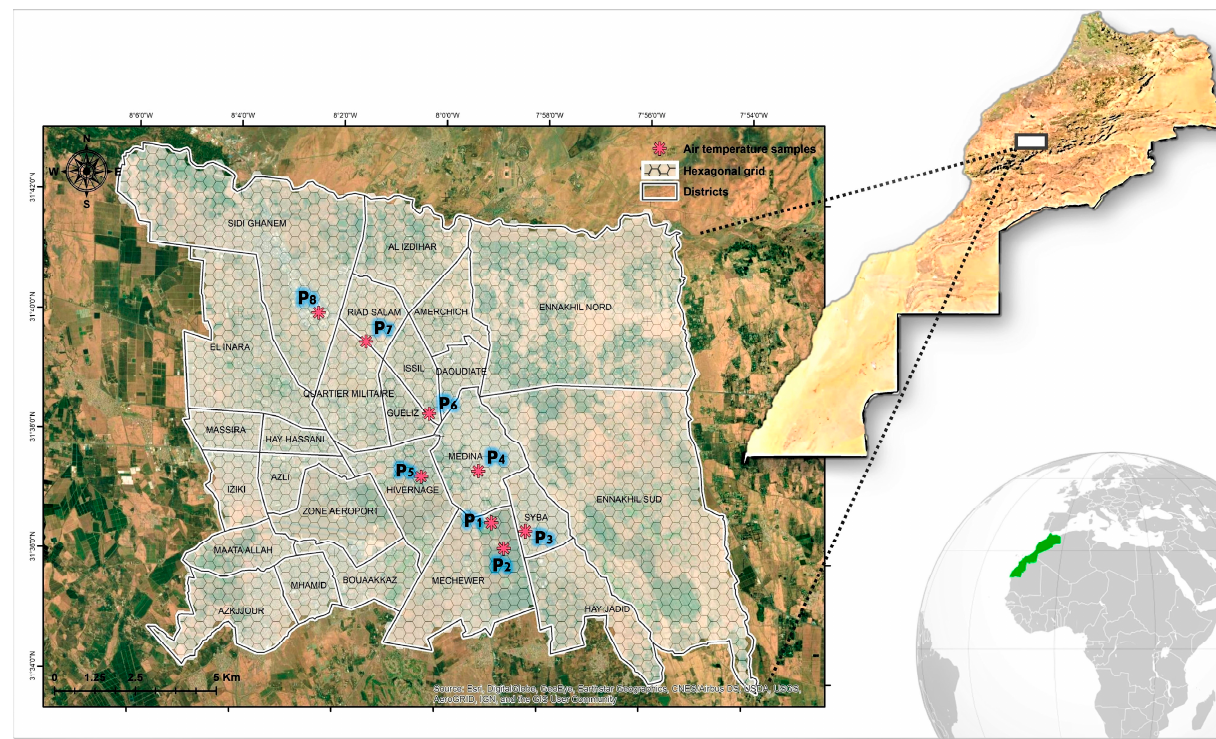
Figure 1. Location of the study area, air temperature samples, districts and hexagonal grid used. Marrakesh is characterised by a semi-arid continental climate. Its average annual temperature is around 20 ◦ C with peaks of around 40 ◦ C. Rainfall periods are between November and April and reach a climatological mean annual total that fluctuates between 150 and 350 mm/year. Outside the rainy season, the atmosphere remains dry with a high evaporative